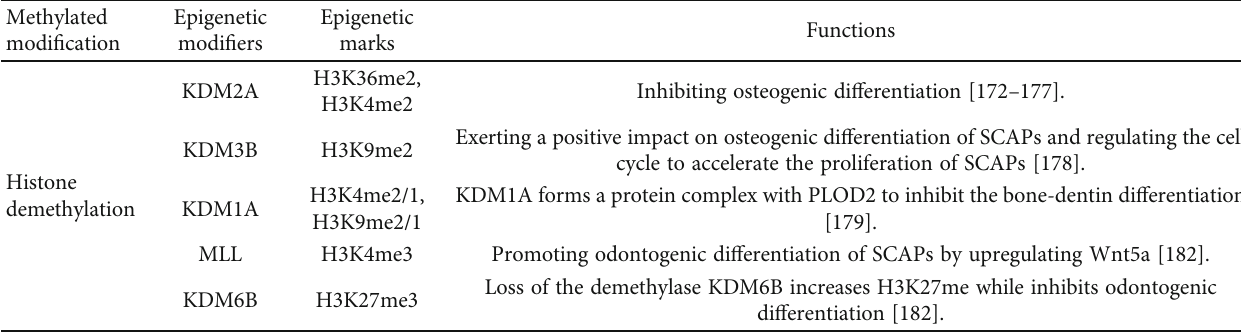
Table 4: Methylation and demethylation in